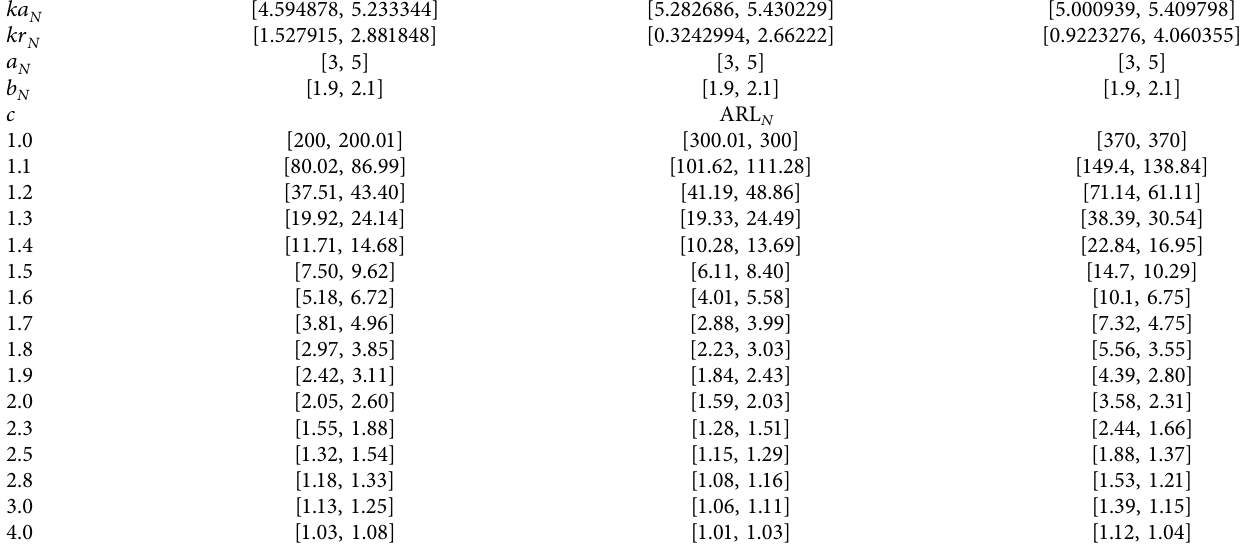
[ 3 , 5 ] and b [ 1 . 9 , 2 . 1 ] . N ∈ N ∈